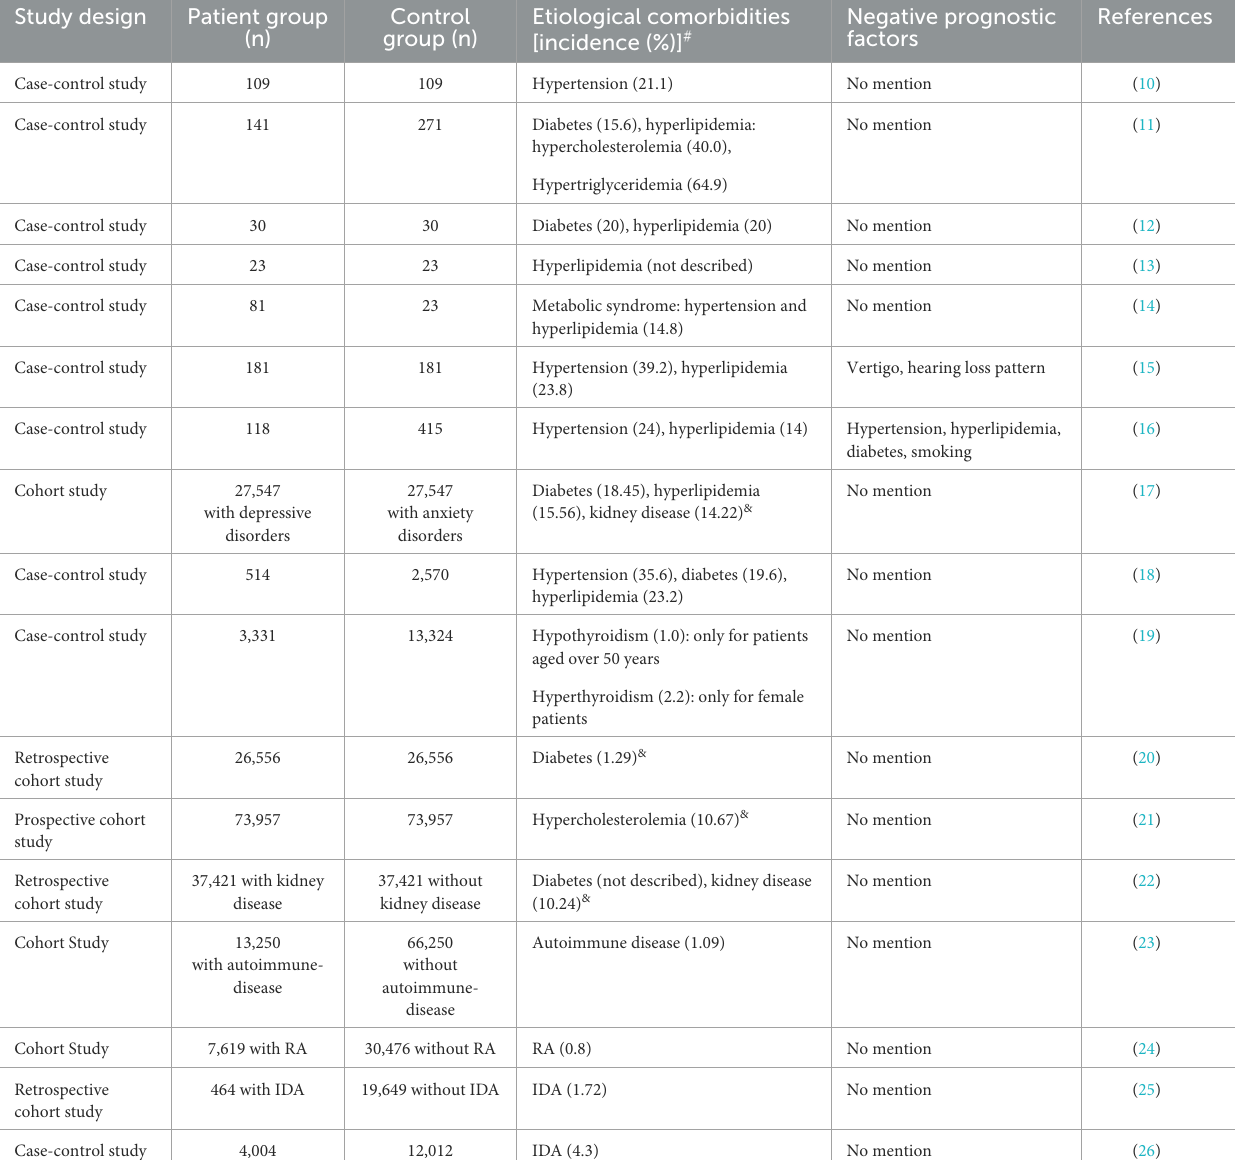
TABLE 1 Previous studies about the etiological comorbidities of